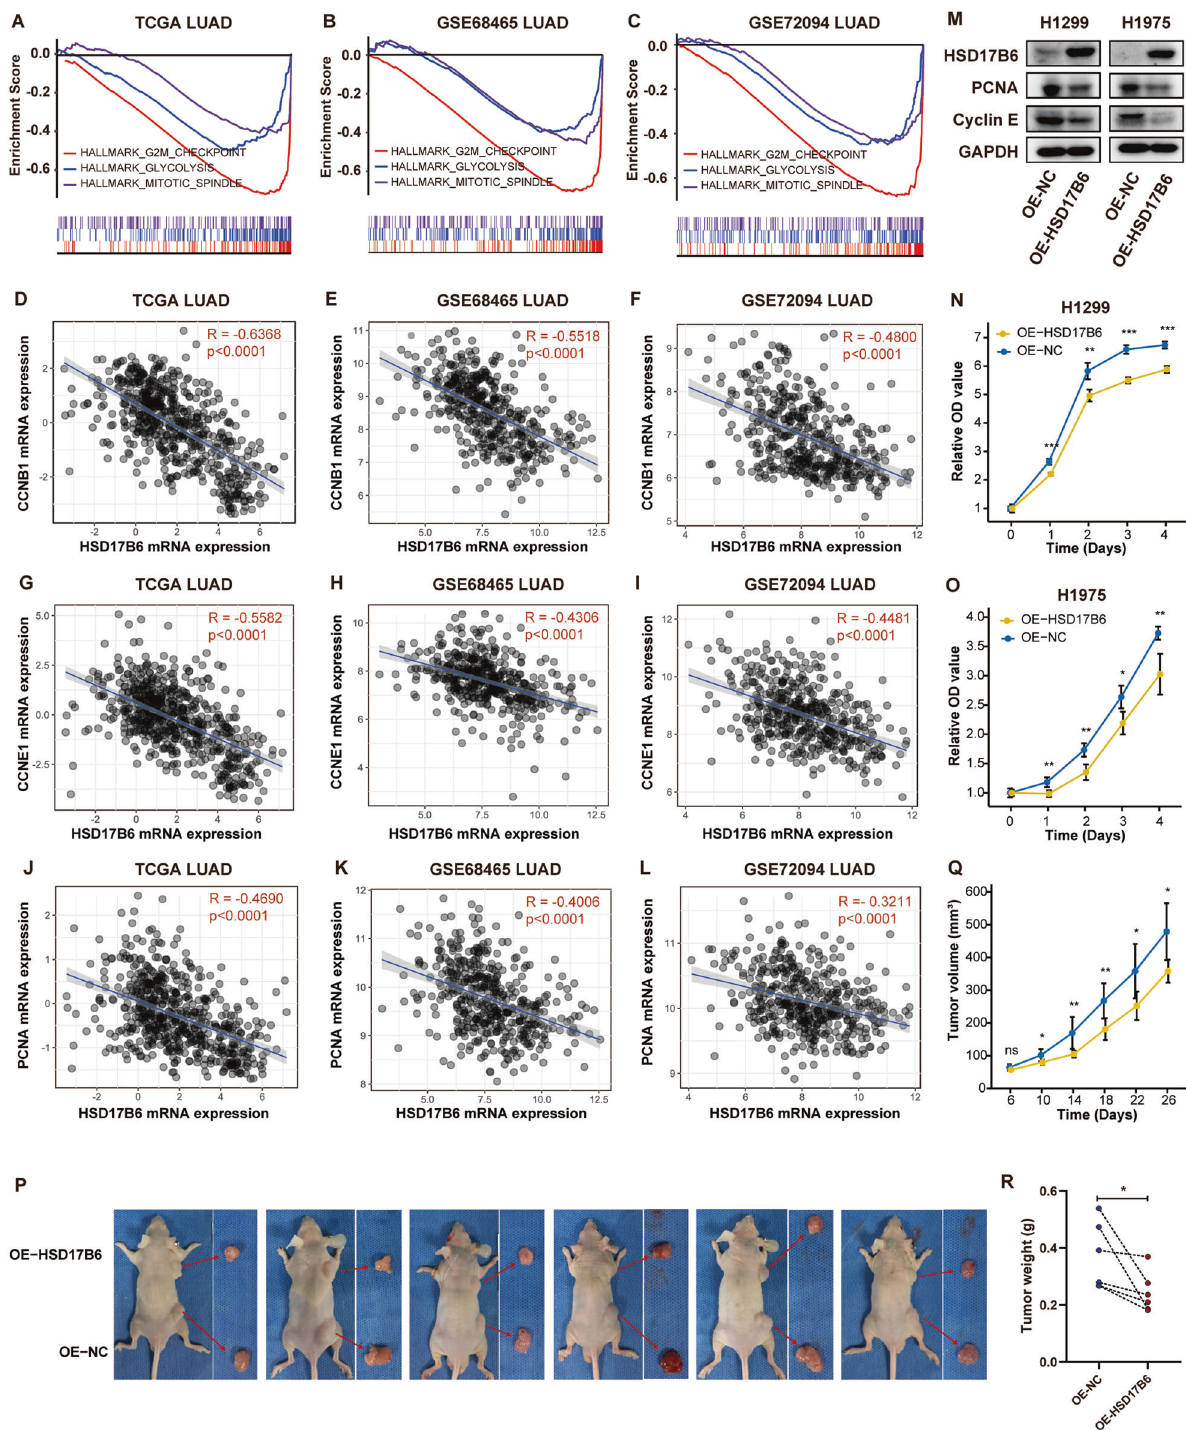
Fig. 5 HSD17B6 impedes proliferation of LUAD cells. A – C GSEA analysis in TCGA LUAD, GSE68465, and GSE72094 LUAD showed that HSD17B6 expression levels were negatively correlated with gene signatures of “ HALLMARK GLYCOLYSIS ” , “ HALLMARK G2M CHECKPOINT ” , and “ HALLMARK MITOTIC SPINDLE ” . D – F Correlation of HSD17B6 mRNA expression with CCNB1 mRNA expression in TCGA LUAD, GSE68465, and GSE72094 LUAD. G – I Correlation of HSD17B6 mRNA expression with CCNE1 mRNA expression in TCGA LUAD, GSE68465, and GSE72094 LUAD. J – L Correlation of HSD17B6 mRNA expression with PCNA mRNA expression in TCGA LUAD, GSE68465, and GSE72094 LUAD. M Protein levels of HSD17B6, Cyclin E, and PCNA were assessed by western blotting after HSD17B6 overexpression. N , O The effect of HSD17B6 overexpression on cell proliferation of H1299 and H1975, as determined using the CCK-8 assay. P Six nude mice carrying subcutaneous tumors of HSD17B6- overexpressing H1299 group (top) and control group (bottom) were shown. Q Tumor diameter in six mice was measured every 4 days. The tumor volume was calculated and tumor growth curves were plotted over time. R Tumor weights were measured and compared between two groups. OE-NC: negative control for overexpression; OE-HSD17B6: HSD17B6 overexpression. *** p < 0.001, ** p < 0.01, * p < 0.05.